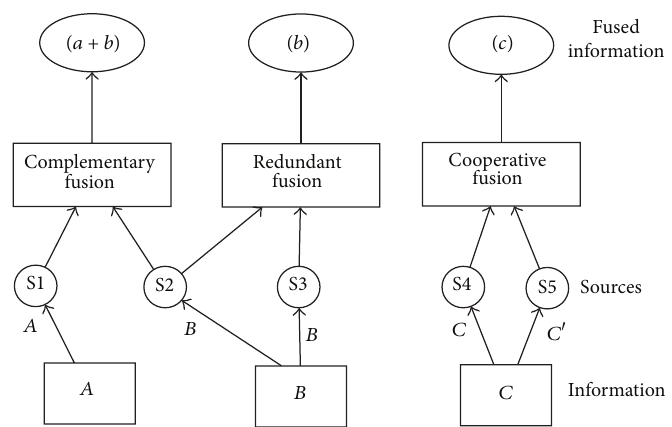
Figure 1: Whyte’s classification based on the relations between the data sources.